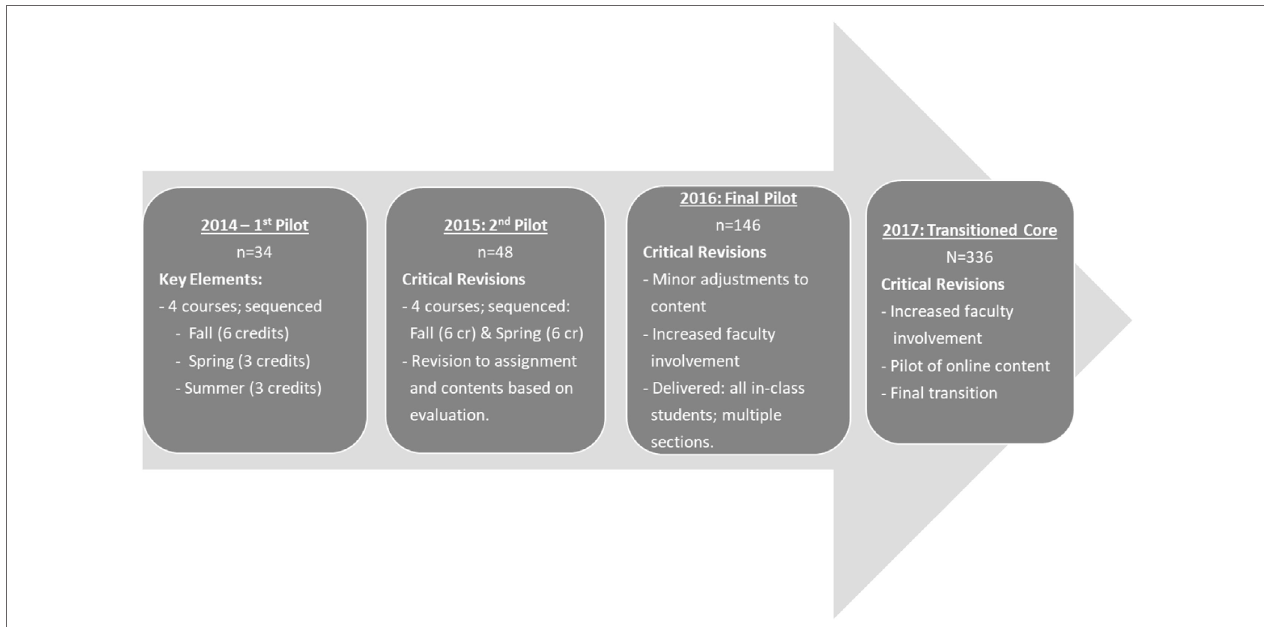
Figure 1 | Transitioning the Masters in Public Health